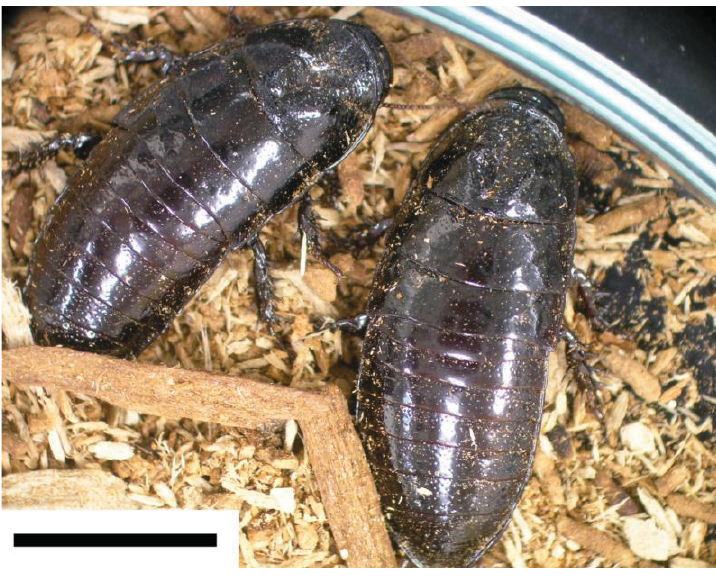
Figure 1. Pairs of Cryptocercus punctulatus collected at Mt. Collins (male chromosome number 2n = 45), North Carolina, eastern United States. Scale bars indicate 10